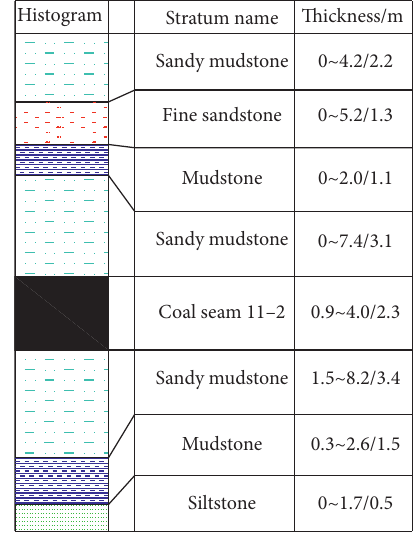
Figure 10: Histogram of coal-rock strata in the working